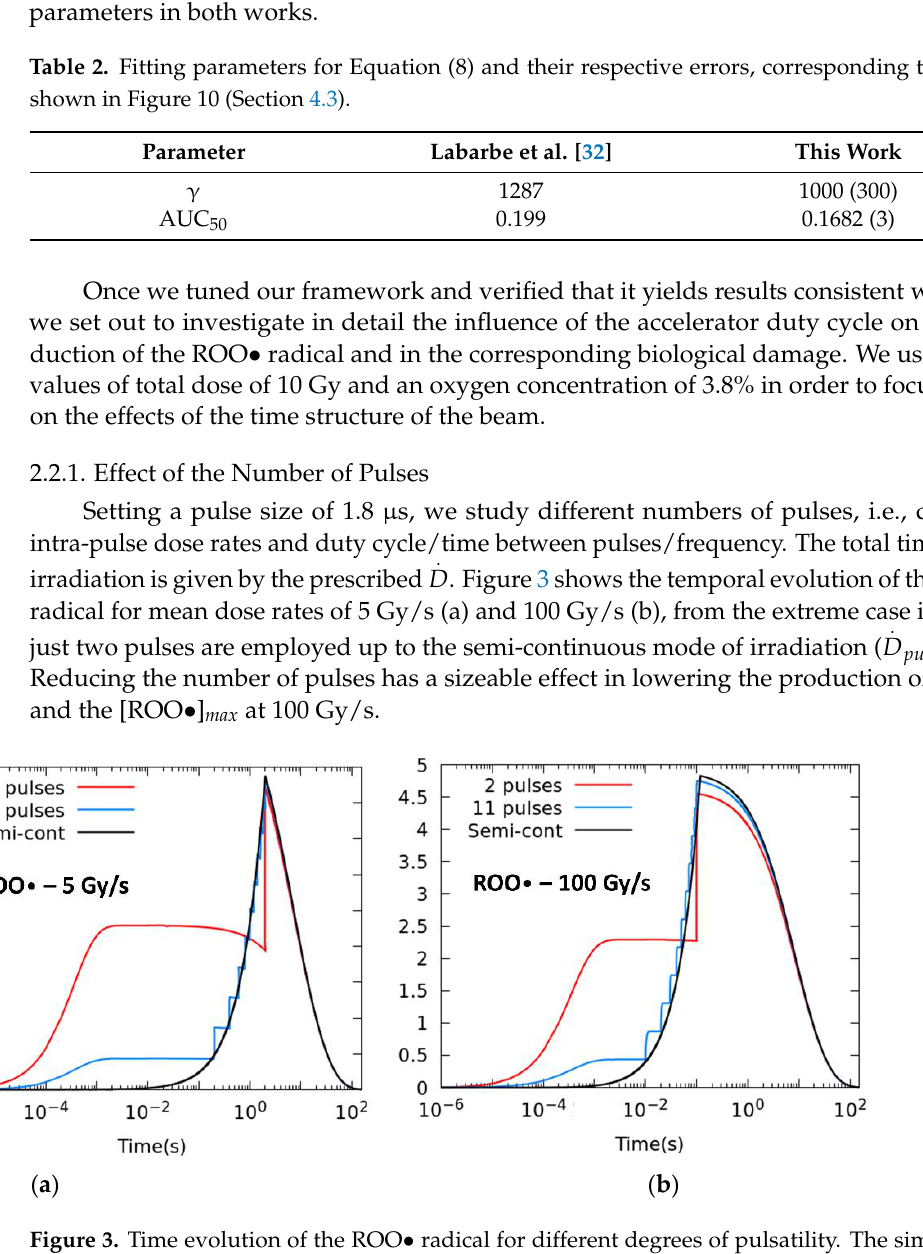
Table 3. Integral production of the ROO• radical for mean dose rates of 5 and 100 Gy/s and corre- sponding irradiation parameters used in the simulations of different pulse repetition frequencies, keeping the pulse width to 1.8 μs. Reported data uncertainties correspond to on e standard devia- tion.